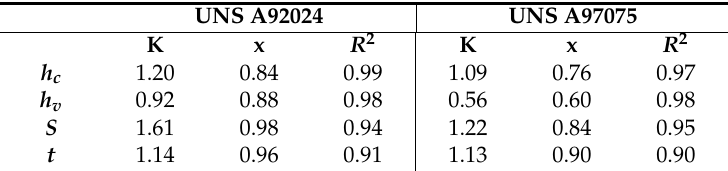
Table 5. Values of the coefficients obtained in the potential relationship from Equation (9). UNS A92024 UNS A97075 K x R 2 K x R 2 h c 1.20 0.84 0.99 1.09 0.76 0.97